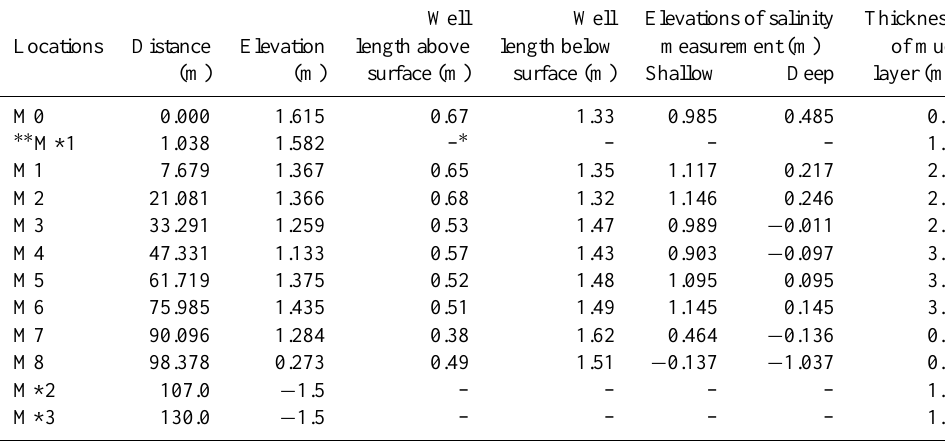
Table 1. Locations and depths of wells at the mangrove transect M-M 0 .